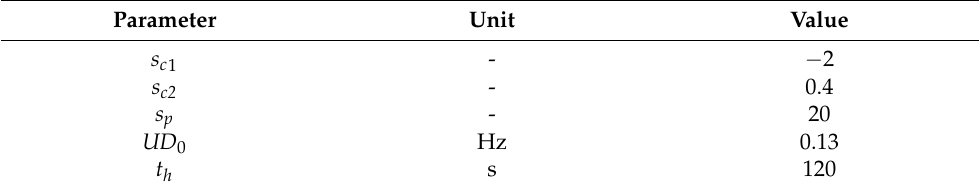
Table 1. Parameters of the causal ECMS-based control strategy.